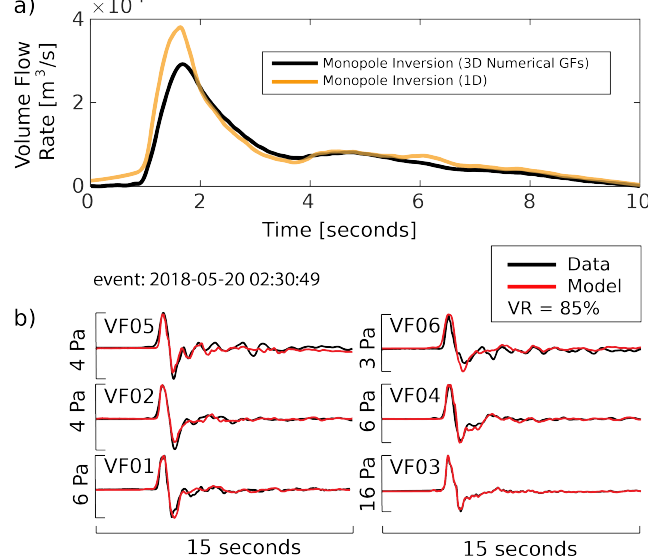
Figure 9. Monopole source inversion using 3D numerical Green’s functions for an explosion recorded at Fuego volcano (Guatemala): ( a ) comparison of volume flow rates retrieved by monopole source inversion using 3D and 1D Green’s functions (black and yellow, respectively); and ( b ) plot of waveform fit between recorded infrasound and best model from 3D monopole inversion. VR is variance reduction (please, see Equation (14) in main